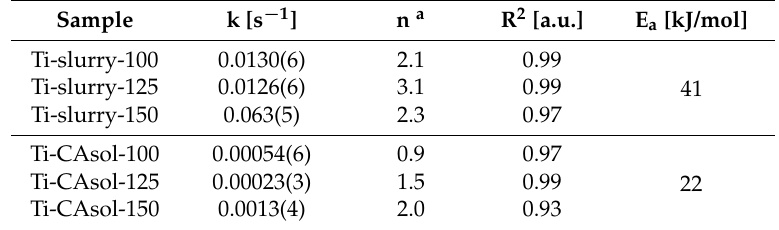
Table 2. Fitted parameters for the growth of BT from in situ X-ray diffraction and the activation energy for the Ti-CAsol and Ti-slurry experiments.